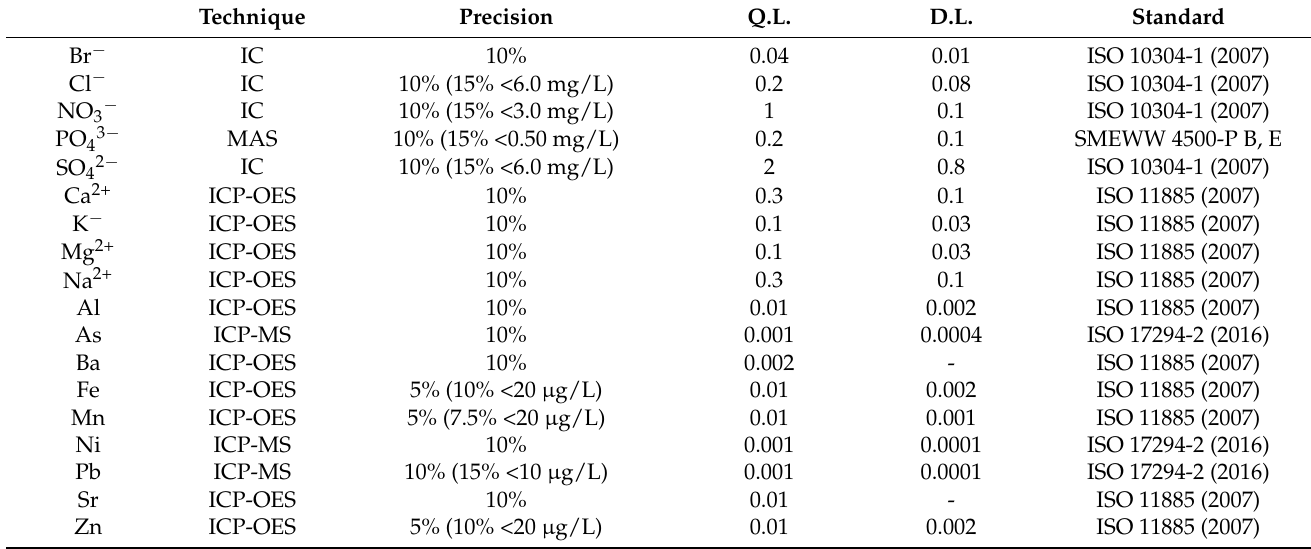
Table 2. Laboratory analysis techniques; their precision, quantification and detection limits (mg/L); and standards used to determine the major and minor